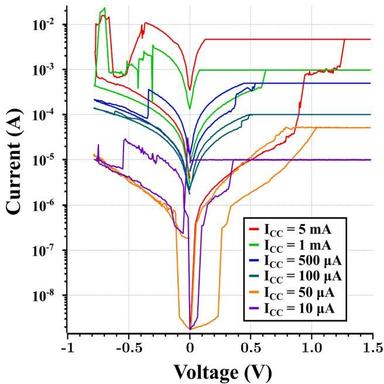
I-V characteristics of a bipolar Cu/HfO2/Pt memristor for different current compliances.